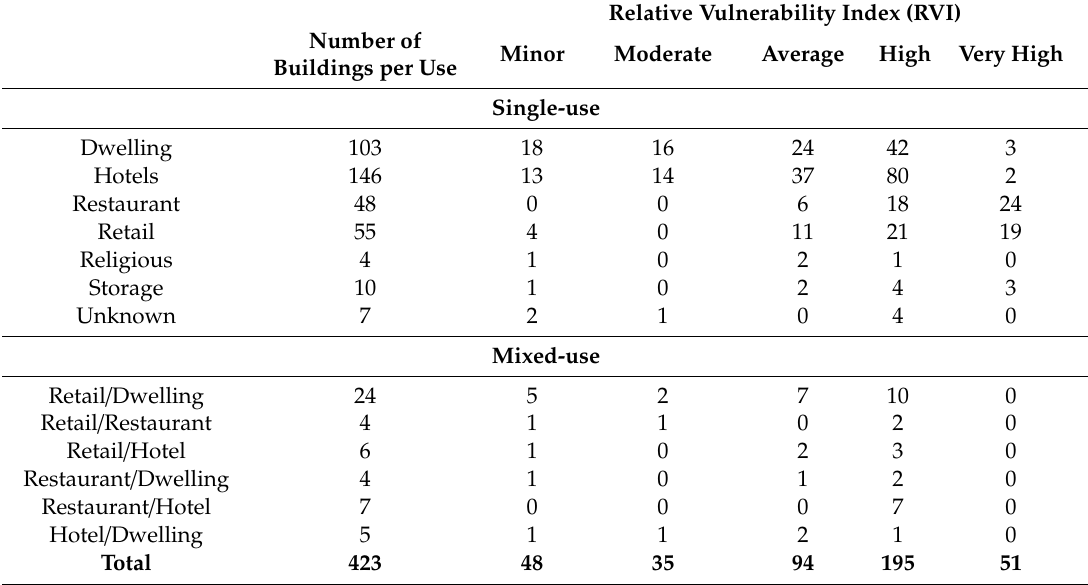
Table 3. Relative Vulnerability Index (RVI) in relation to the use of the